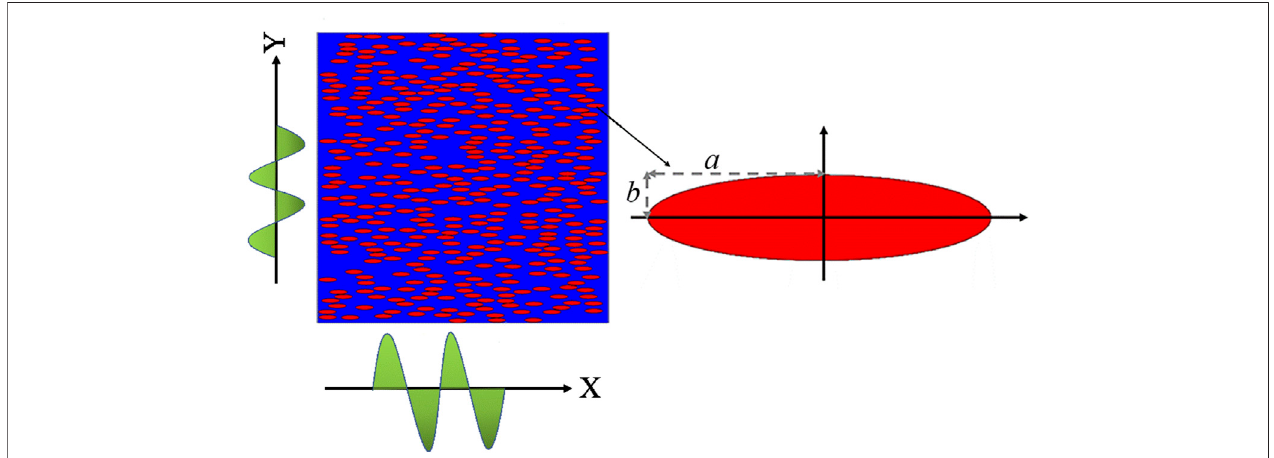
FIGURE 1 | Schematic of a nonlinear thermal composite. All the ellipse inclusions have the same shapes and orientations (main axes are along the x axis). Nonlinearity isintensi fi ed in the x direction, while it is weakened in the y direction, coming into directionalnonlinearity enhancement. Ellipse inclusions are ampli fi ed at the right hand. a and b are the semi-axis length in the x and y direction,